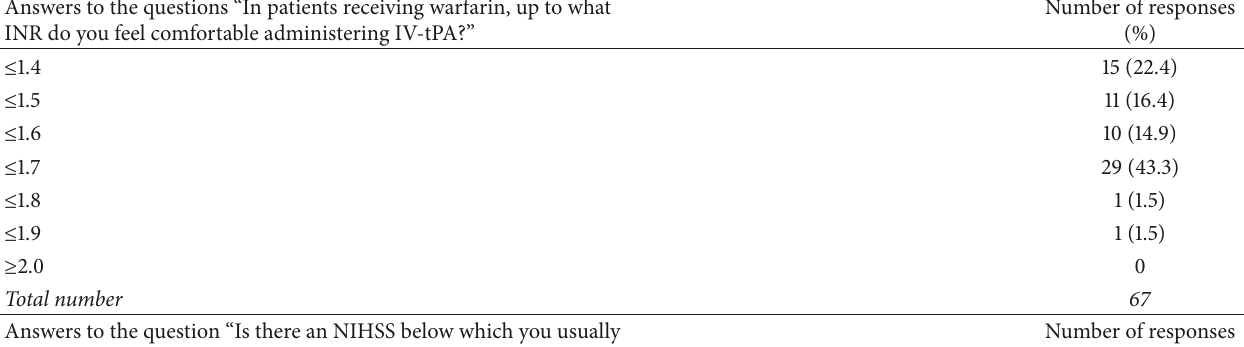
Table 3: Number and percentage of neurologists who would administer IVT based on an INR value or NIHSS score. Answers to the questions “In patients receiving warfarin, up to